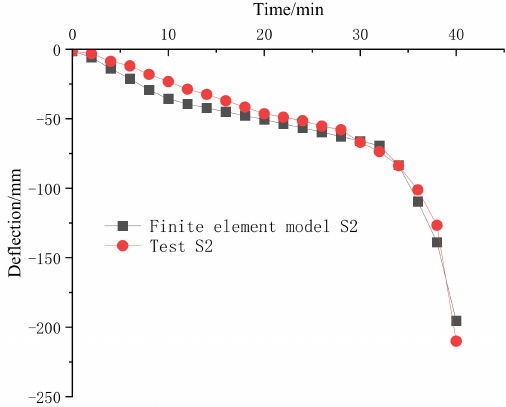
Figure 6. MID-span deflection time